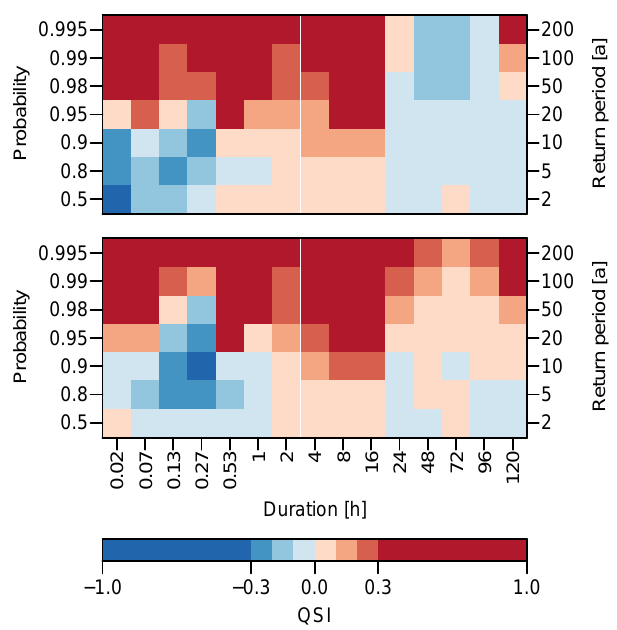
Figure 3. Average Quantile Skill Index QSI d ( p ) for different durations d and probabilities p . Upper panel: station-wise d-GEV. Lower panel: spatial d-GEV. Positive values (red) indicate duration